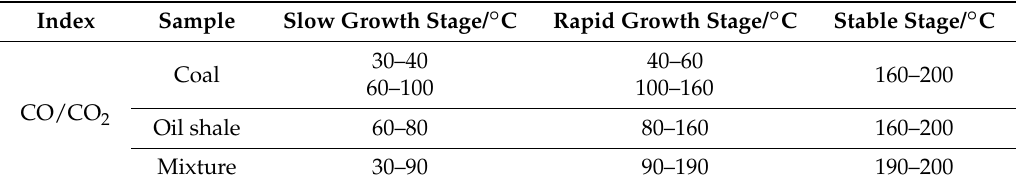
Table 4. Three sample stages divided with respect to the CO/CO 2 ratio.